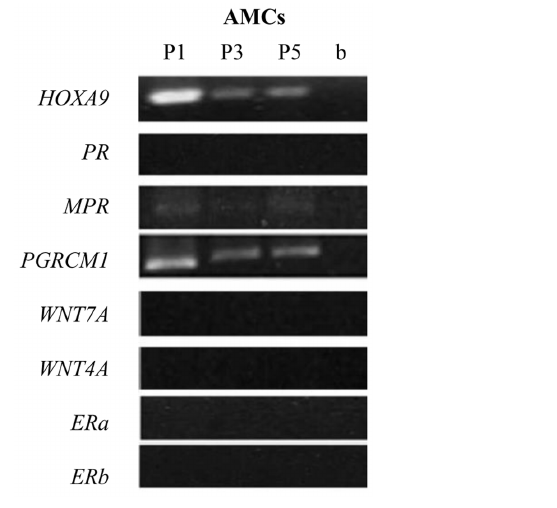
Figure 3. Molecular characterization of AMCs. Conventional RT-PCR analysis of evaluated genes in AMCs after culture with progesterone from passage 1 (P1) to passage (P5).